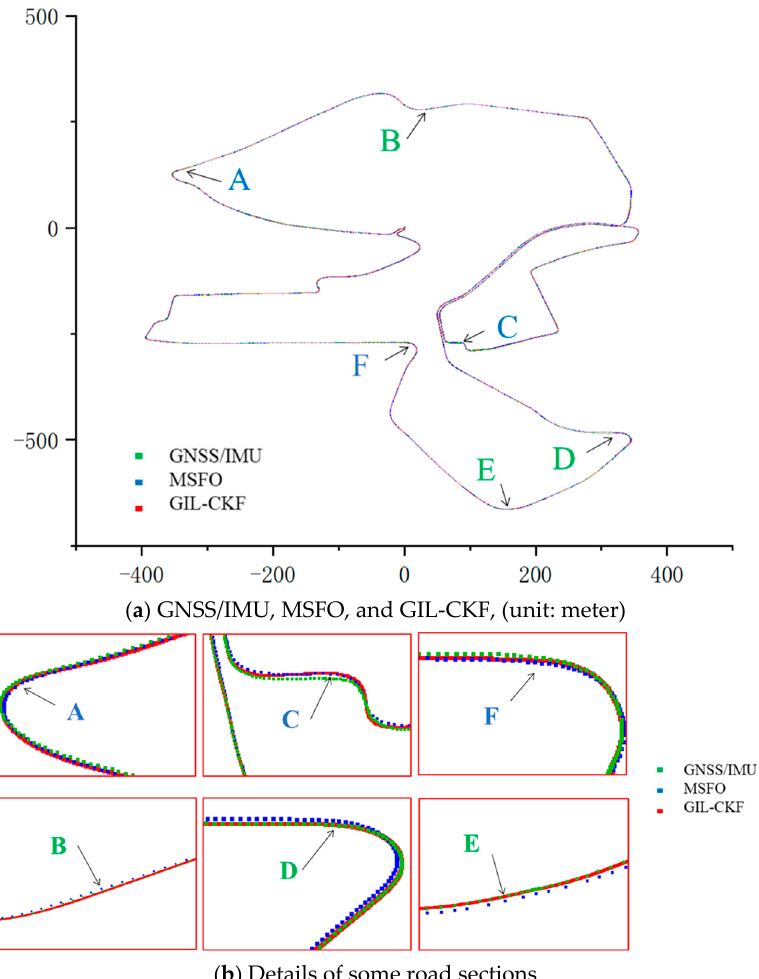
Figure 16. The trajectory of the complete scheme of the factor graph and filtering cooperation. Table 3. GNSS/MSFO/GIL-CKF relative accuracy (unit: meter).